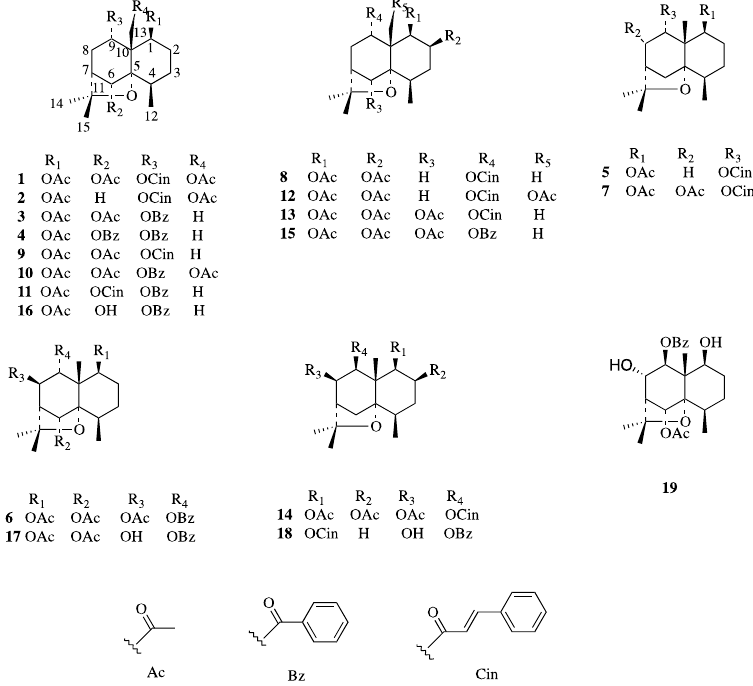
Figure 1. Structures of the β‐ dihydroagarofuran sesquiterpenes ( 1 – 19 ) assayed for their anti ‐ Figure proliferative activity.